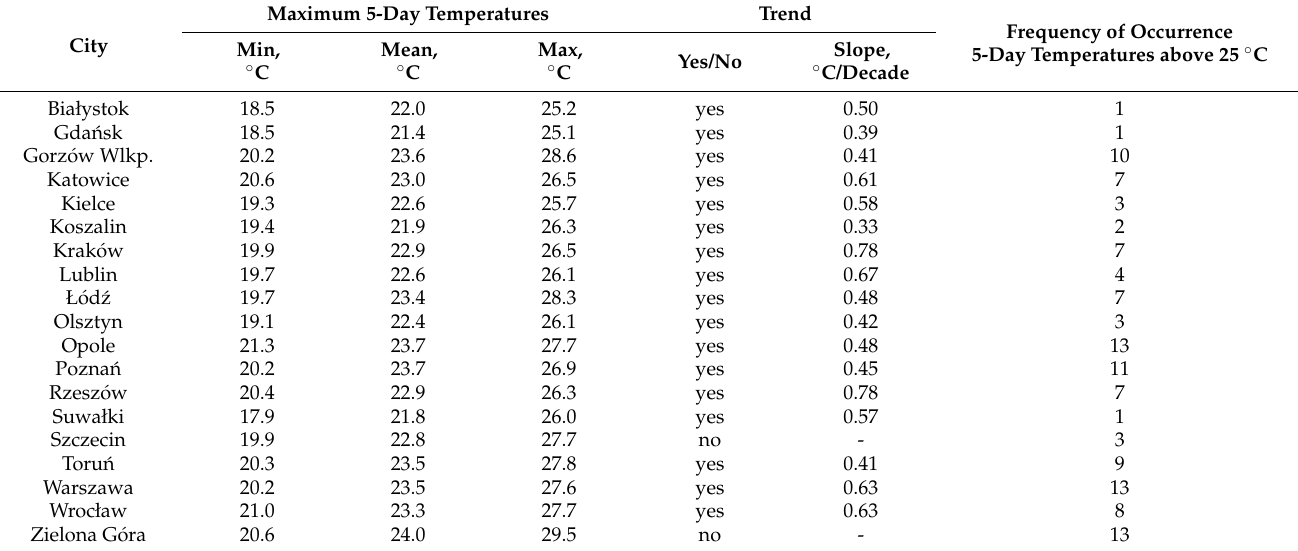
Table 3. Analysis of the maximum five-day temperatures between 1970 and